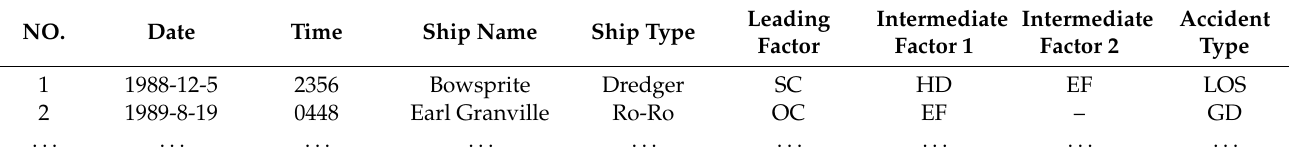
Table 1. Accident information